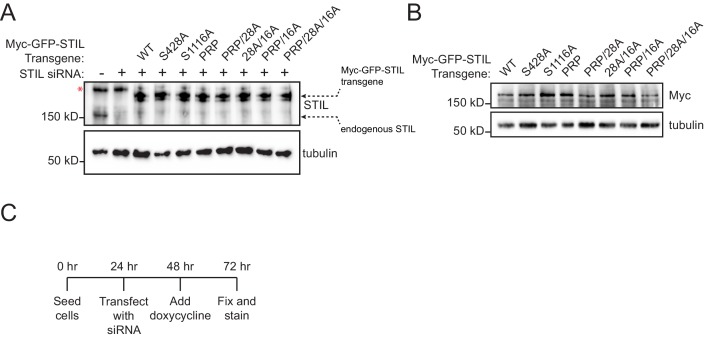
STIL transgenes are expressed to similar levels.(A) Immunoblot showing the Myc-GFP-STIL transgene expression levels compared to endogenous STIL. Note that a background band (denoted by a red asterisk) is present in the non-transgenic cell lines. (B) Immunoblot showing only Myc-GFP-STIL transgene expression levels after knockdown of endogenous STIL. (C) Experimental outline for the STIL RNAi-replacement experiments.